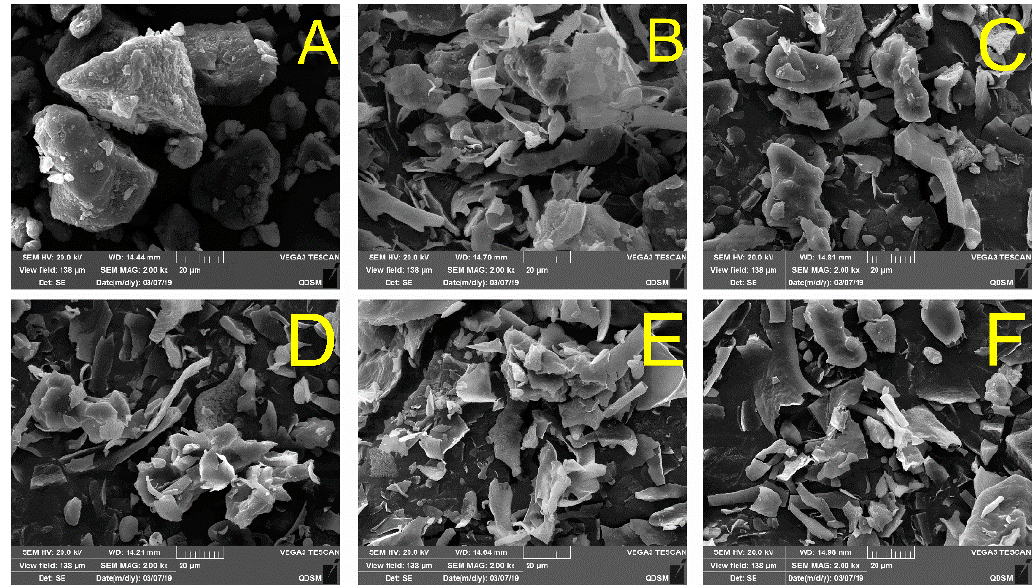
Figure 6. SEM images of ( A ) control and HP-treated oyster proteins by ( B ) 100 MPa, ( C ) 200 MPa, ( D ) 300 MPa, ( E ) 400 MPa, and ( F ) 500 MPa, respectively.